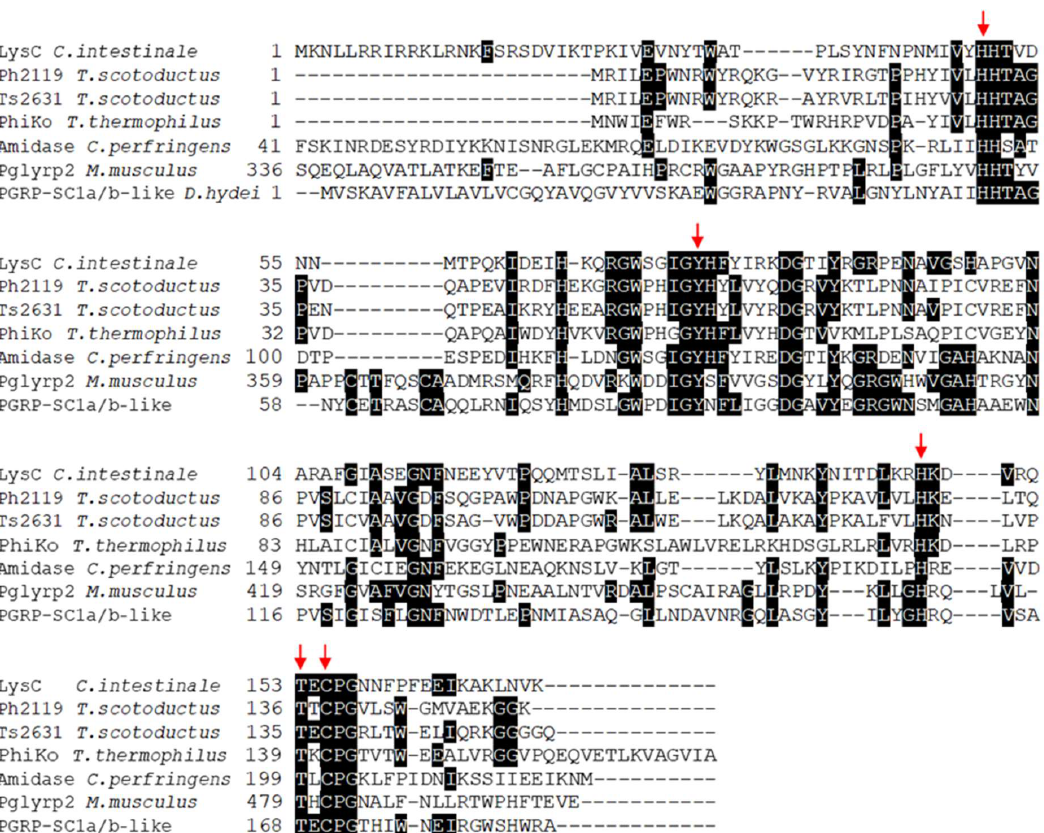
Figure 1. Multiple-sequence alignment of amino acid sequences of LysC lytic enzyme, Ph2119 and Ts2631 endolysins, N -acetylmuramoyl- L -alanine amidase from Clostridium perfringens, and eukaryotic peptidoglycan recognition proteins. The alignment was performed using Clustal Omega. Black boxes highlight conserved amino acids. LysC from C. intestinale URNW with conserved residue pattern similar to that of the thermostable Ph2119 endolysin was chosen for further analysis. The red arrows indicate conserved residues His50, Tyr76, His147, Thr153, and Cys155 of LysC, which are indispensable for amidase activity (https://www.ncbi.nlm.nih.gov/protein/ERK30183.1).